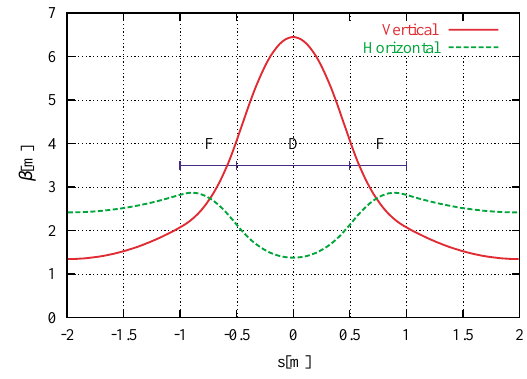
FIG. 5. (Color) Beta function of the lattice.